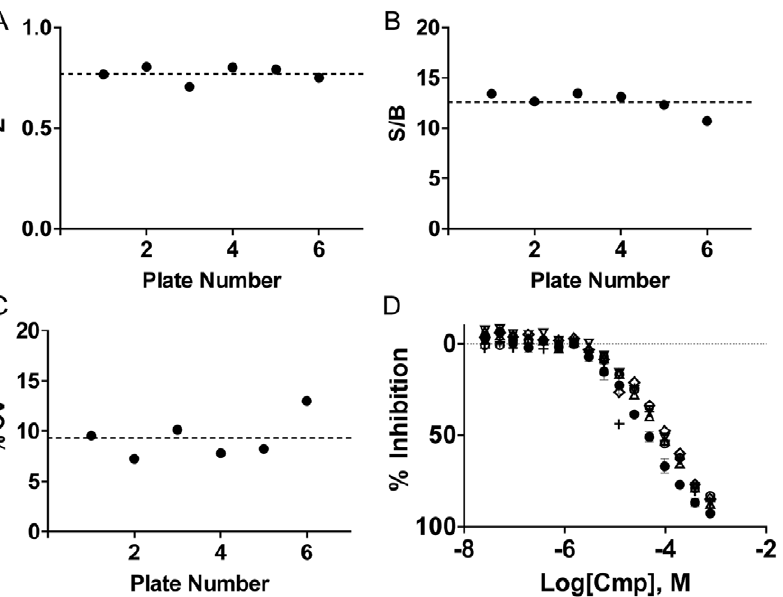
Figure 4. Performance of the PI5P4K a assay in 1536-well assay plates. (A) Z’ factor, (B) signal/background, and (C) % column variance as a function of assay plate. An average Z’ =0.77 6 0.04, S/B =12.6 6 1.04 and % CV =9.32 6 2.1 was achieved for the six plates (reported as average 6 standard deviation). (D) IC 50 data for the control compound AG-82 on the six assay plates depicted with six symbols. MSR of the IC 50 =1.29. Each plate contained 2 16-pt titrations, which were averaged, and the standard deviation is depicted as error bars on the plot (N=2).